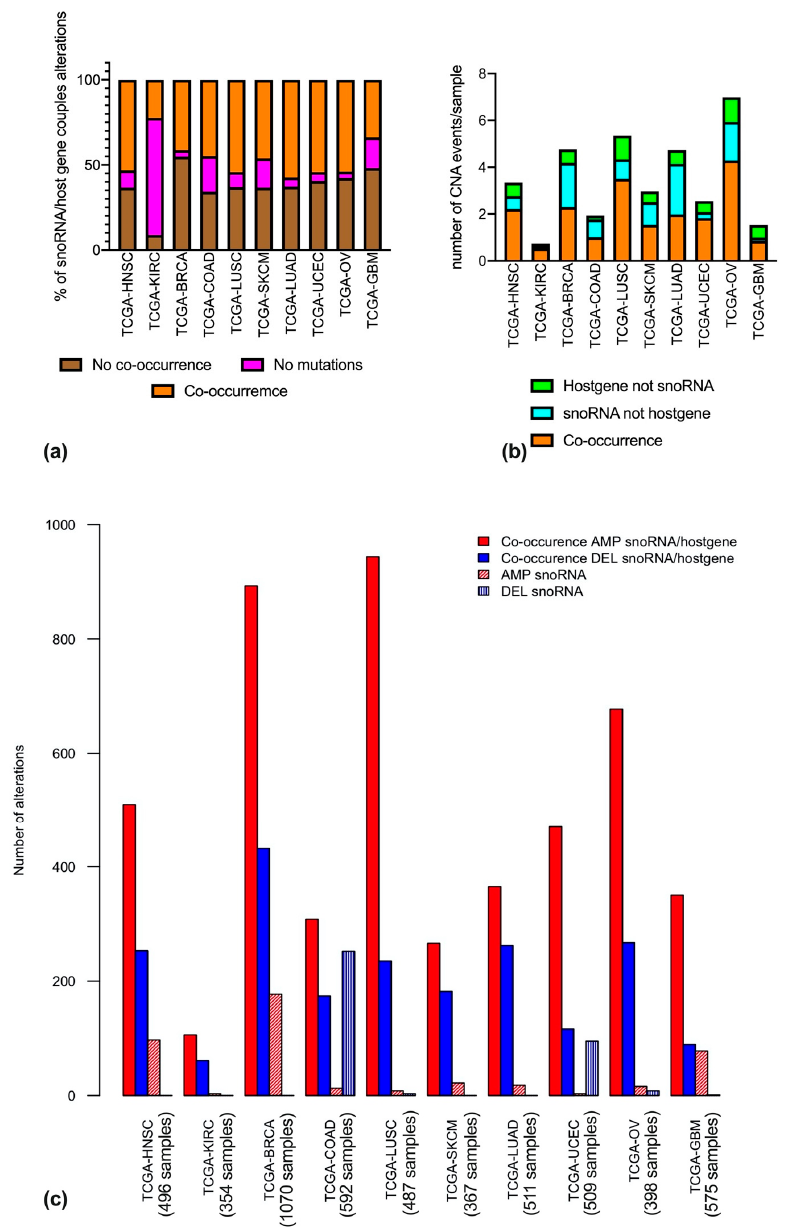
Figure 2. Co-occurrence of CNA in snoRNAs and host genes across different cancer types. ( a ) Percentage of co-occurrence of CNA in snoRNAs and host genes. Orange bars represent co-occurring mutations; brown bars represent mutations that do not co-occur, and purple bars represent absence of mutations. ( b ) Number of CNA events, normalized per sample, and represented with different colors in case of co-occurrence (orange), alteration in snoRNA but not in the host gene (light blue) or alteration in the host gene but not in the snoRNA (green). ( c ) Number of mutational events, split into amplification (red) and deletion (blue), and further into CNAs only involving snoRNAs (textured bars) and CNAs involving both snoRNA and host gene (filled bars).